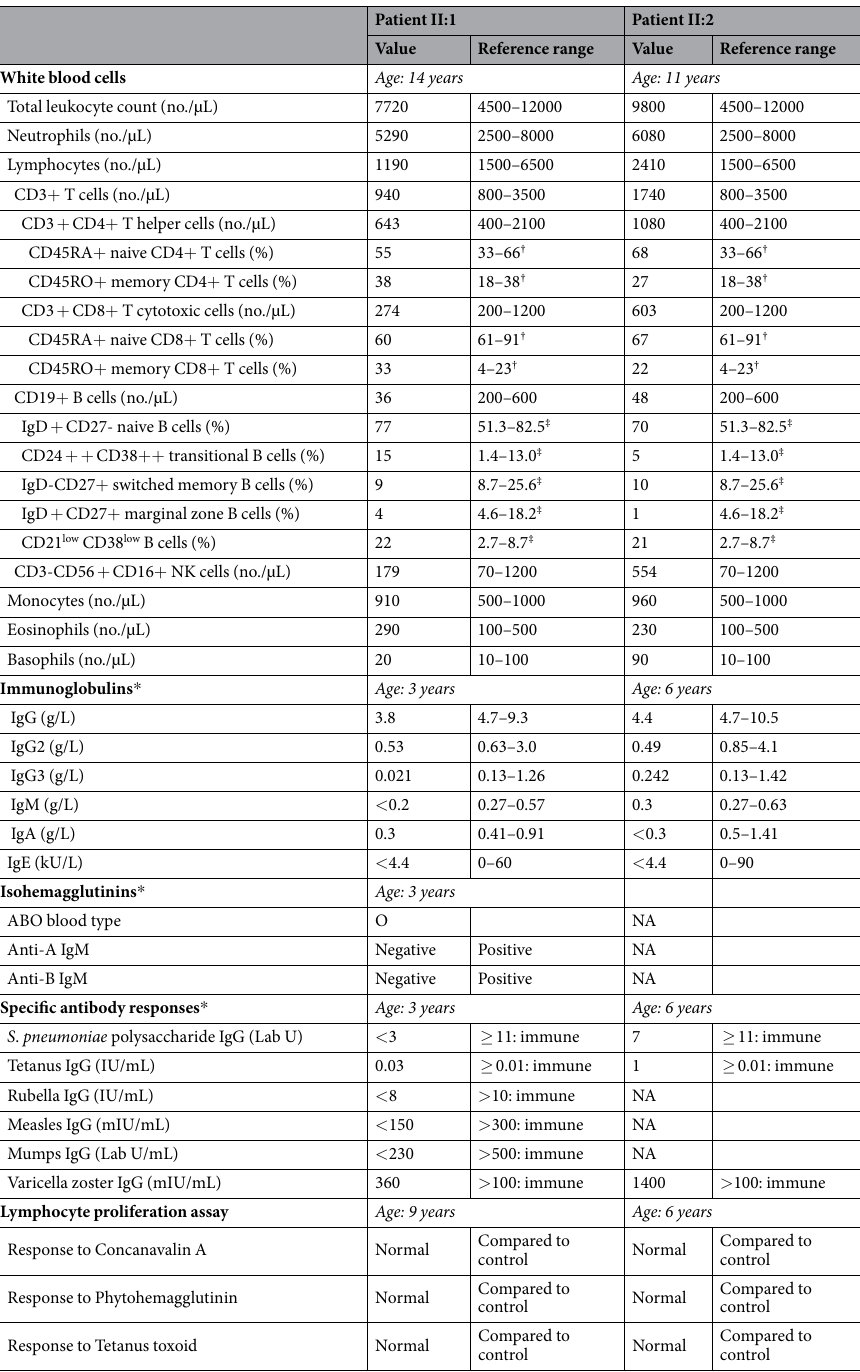
Table 2. Routine immunological laboratory results of the family B patients with Roifman syndrome. The most recent, comprehensive and representative laboratory results are shown for each patient. Both patients were immunized according to the recommended Belgian childhood immunization schedule that, among others, included tetanus, measles, mumps, rubella and 7-valent conjugated pneumococcal vaccines. A polysaccharide (unconjugated) pneumococcal vaccine was given at time of immunological evaluation. The patients were not vaccinated against varicella zoster virus but had chickenpox in early childhood. NA: not available. * Measured when not receiving immunoglobulin replacement therapy. † Reference values from Shearer et al . 27 . ‡ Reference values from Piatosa et al . 28